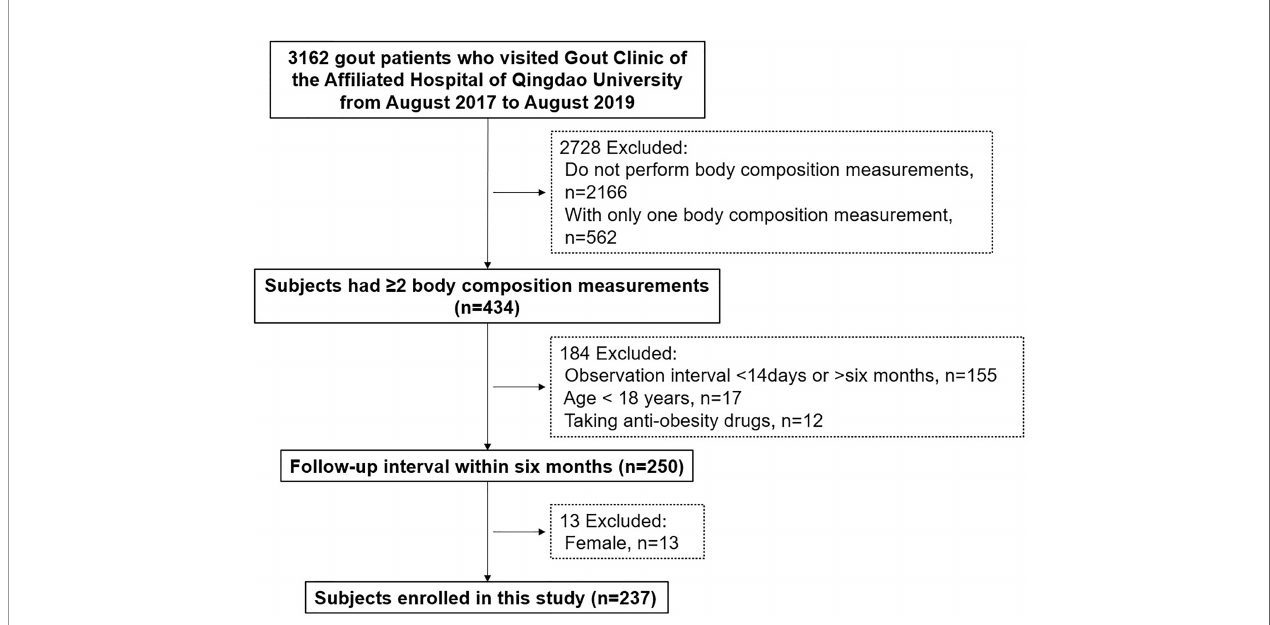
FIGURE 1 | Study fl ow